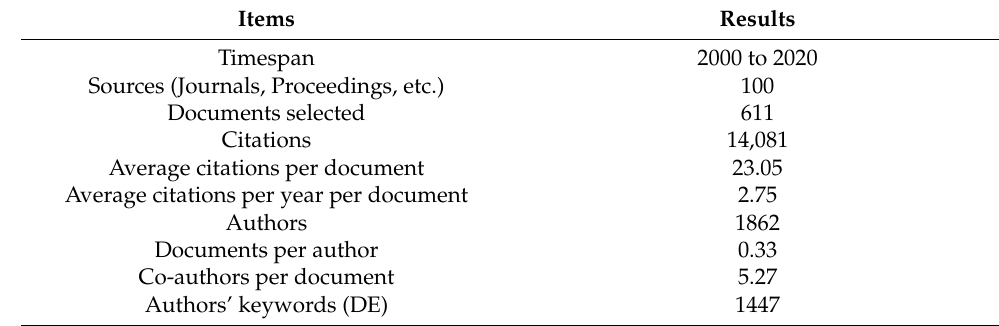
Table 1. Summary of the information retrieved and selected for bibliometric